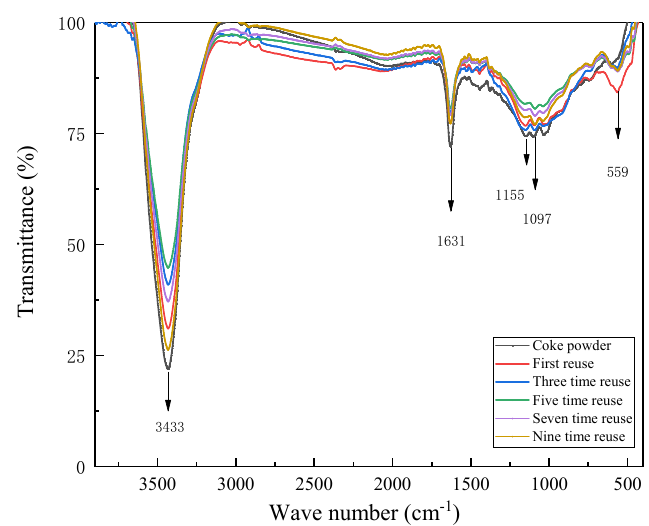
Figure 13. FT-IR results of coke powder adsorbent before and after heat treatment.